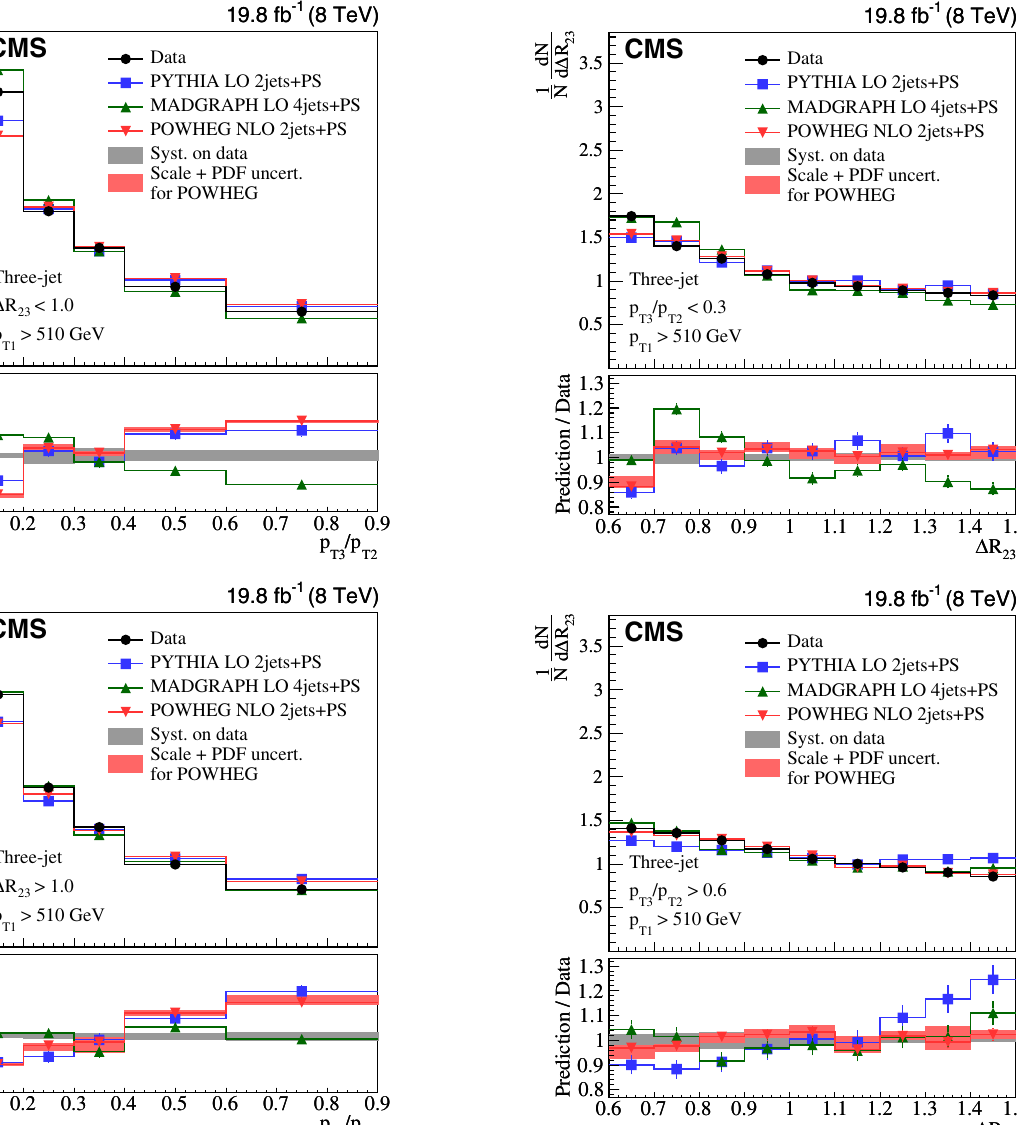
Fig. 2 Three-jet events at p T3 / p T2 for small-angle radiation ( Δ R 23 < 1 . 0), (lower) p T3 / p T2 for large-angle radiation ( Δ R 23 > 1 . 0)